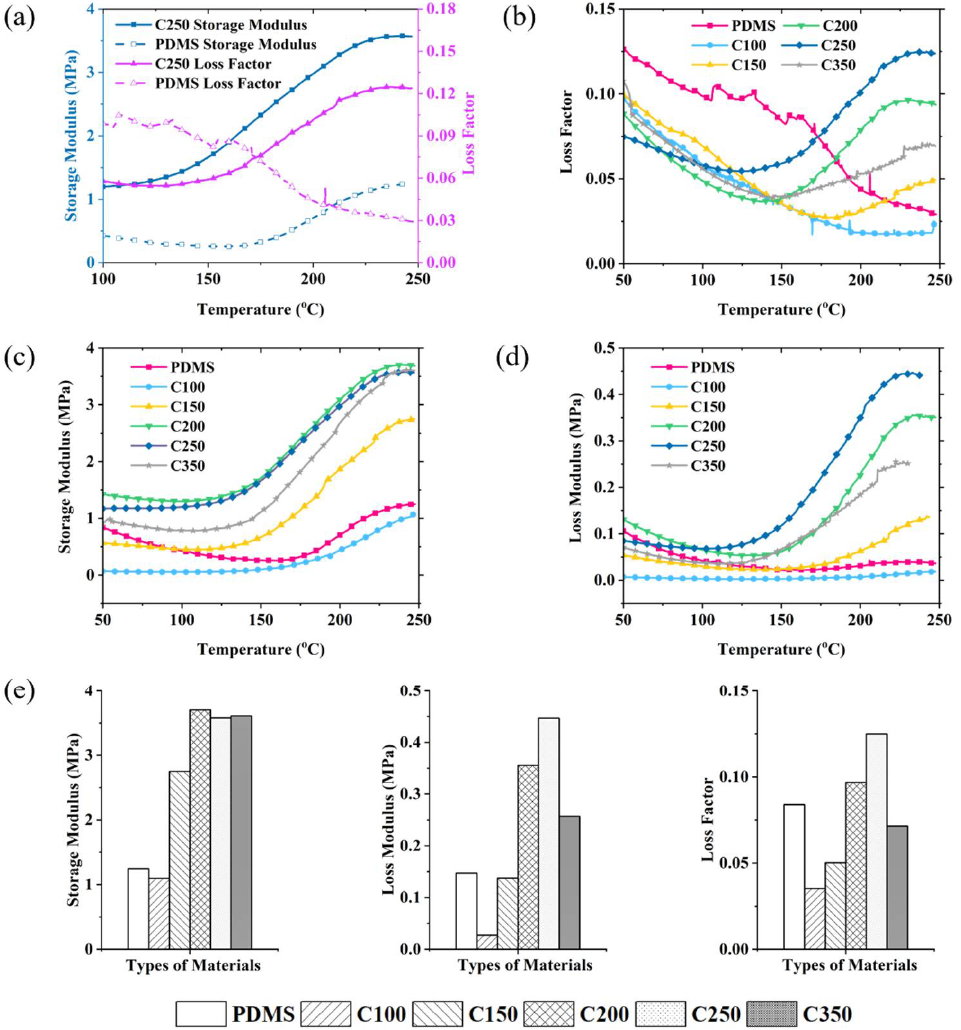
Figure 4. Viscoelastic properties of different GO/PDMS composites. ( a ) is the comparison of storage modulus and loss factor between C250 composite and pure PDMS. ( b – d ) provide information on the loss factor, storage modulus, and loss modulus of different GO/PDMS composites. ( e ) summarizes the comparison of the storage modulus, loss modulus, and loss factor of different GO/PDMS composites, in the temperature range of 150–250 °C. Table 1. The storage modulus, loss modulus, and loss factor of different GO/PDMS composites. Types of